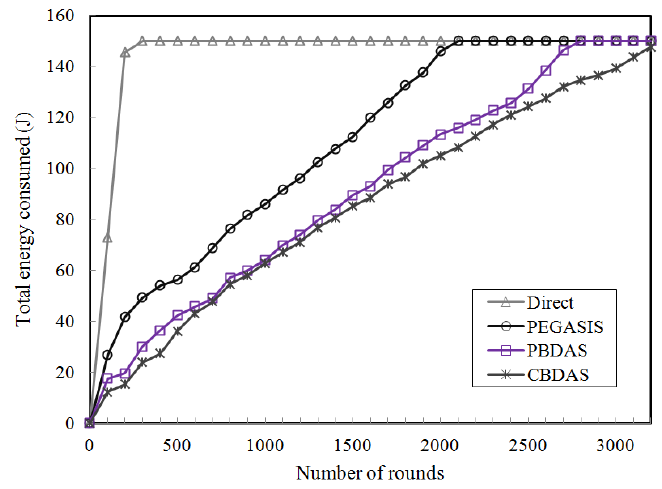
Figure 10. Total consumed energy over